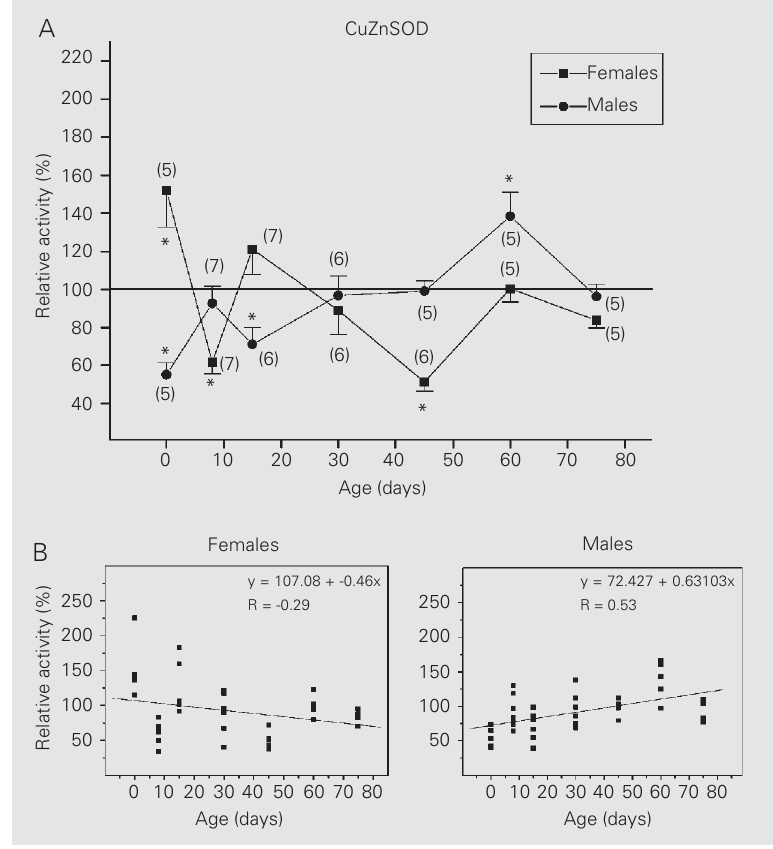
Figure 2. A , Effects of estradiol benzoate on copper,zinc-superoxide dismutase (CuZnSOD) activity in female and male rats of different ages. Data are reported as means ± SEM as percent of olive oil control values for the number of rats given in parentheses (*P<0.05, t - test). B , Scatter-plot of CuZnSOD activity. P - significance of slope for females (P<0.01) and males (P<0.001),